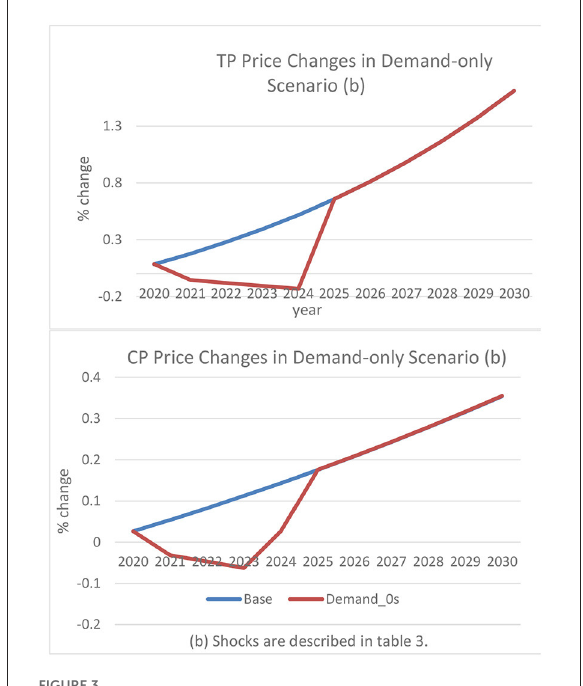
FIGURE3 Traditional and commercial pig price changes in demand-only scenario. (b) Shocks are described in Table 3.